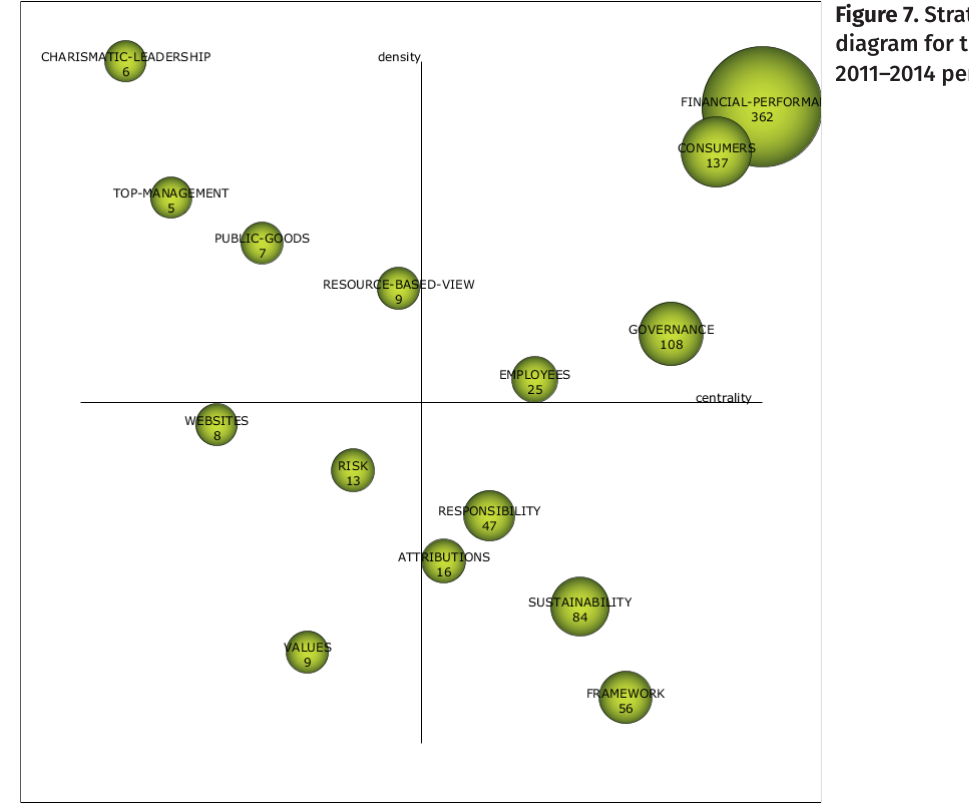
Figure 7. Strategic diagram for